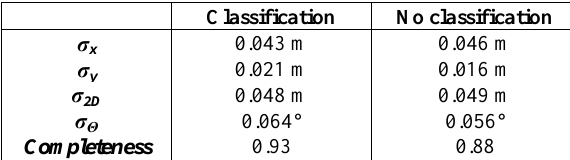
Table 2: Localization results with and without a classification of dynamic points.